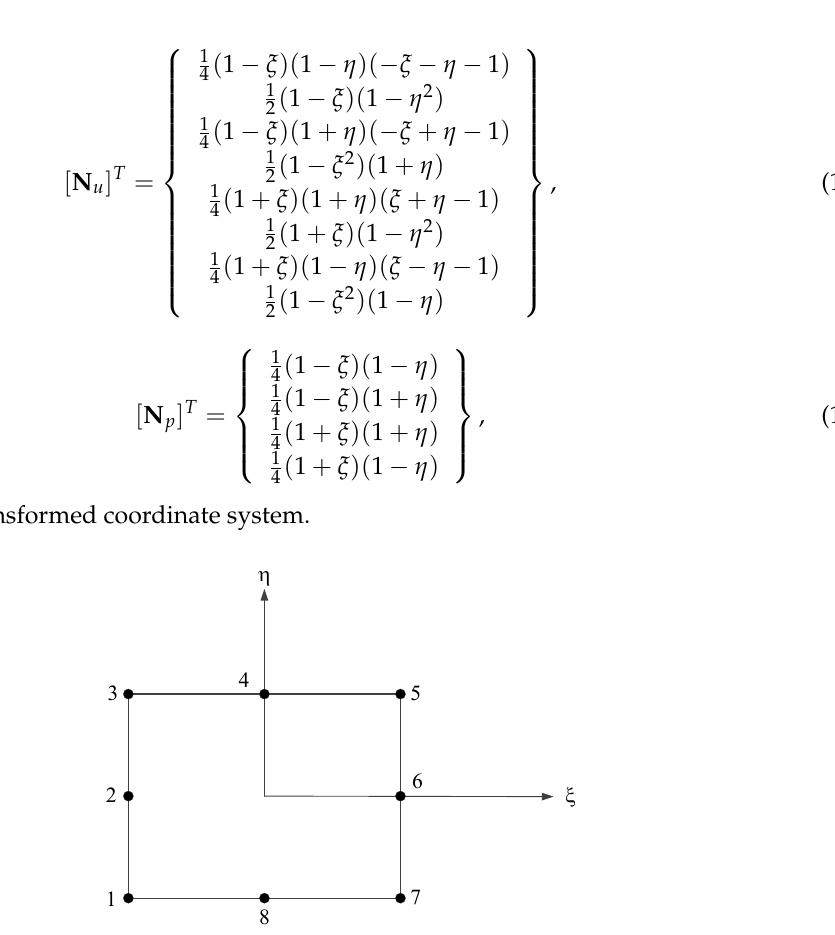
Figure 3. Nodal points of rectangular